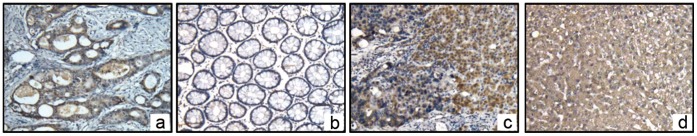
OPN protein localization in the CRC and its liver metastasis visualized by immunohistochemistry. aIn IHC, OPN proteins (brown positive stain) were localized in cytoplasm of CRC cells in primary lesions(x200). b Adjacent normal colorectal tissues were negative(x200). c Positive stain was found both in CRC cells and adjacent normal hepatocytes in liver metastatic tissues(x100). d As controls, OPN proteins stain in normal liver tissues without CRC metastasis was negative(x100).